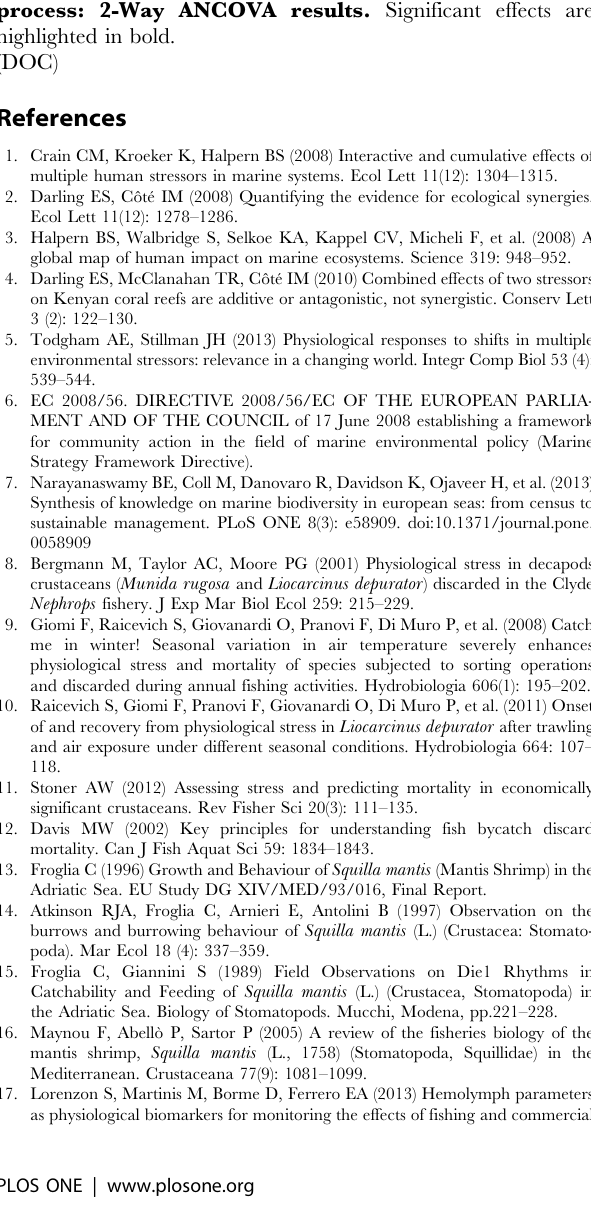
Table S7 Whole recovery experiment: 1-Way ANOVA results. Significant effects are highlighted in